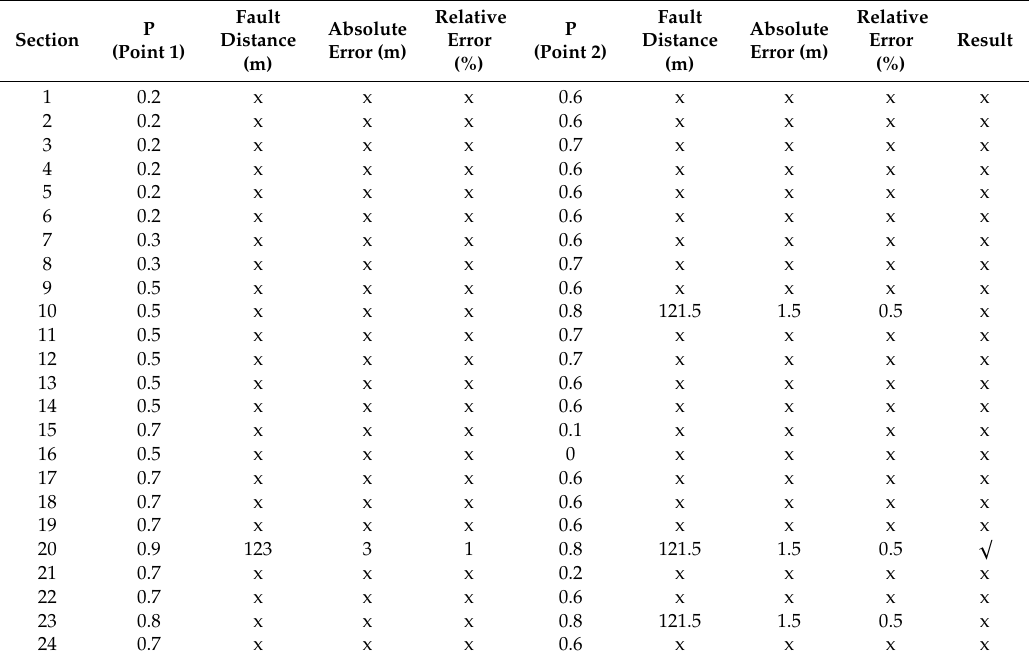
Table 5. Probabilities of fault in each